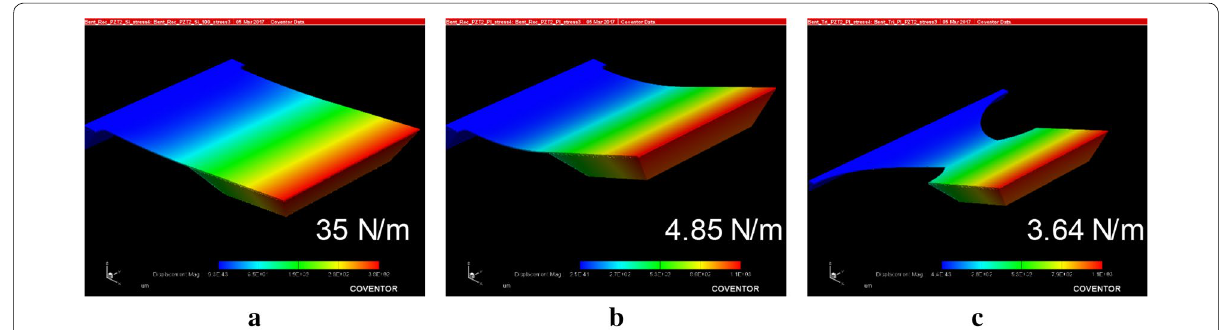
Fig. 2 Simulated spring constants of the designed cantilevers: a rectangular shaped silicon cantilever, b rectangular shaped polyimide cantilever, and c trapezoid shaped polyimide